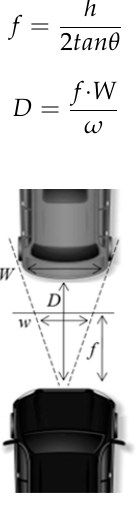
Figure 9. Distance estimation.